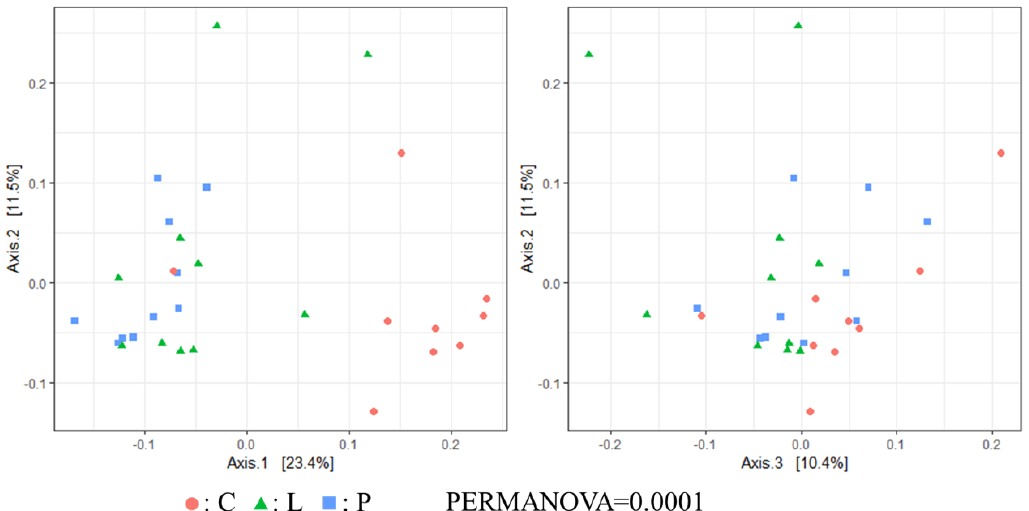
Figure 2. Microbial communities in the gut of experimental hens collected after 5 weeks of black soldier fly (BSF) larvae and pre-pupae dietary supplementation (C: n = 9; L: n = 10; P: n = 10). Unweighted UniFrac distance principal coordinate analysis (PCoA) plots of β -diversity measurement of the microbiota communities. C: control diet; L: larvae diet; P: pre-pupae diet.